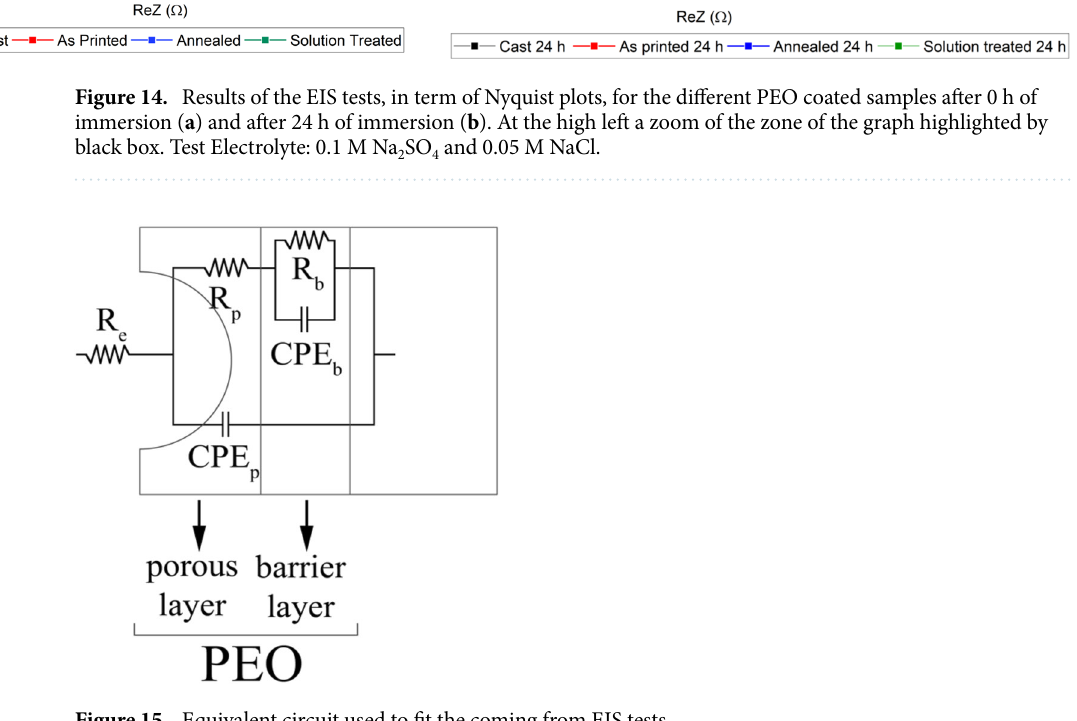
Figure 15. Equivalent circuit used to fit the coming from EIS tests.